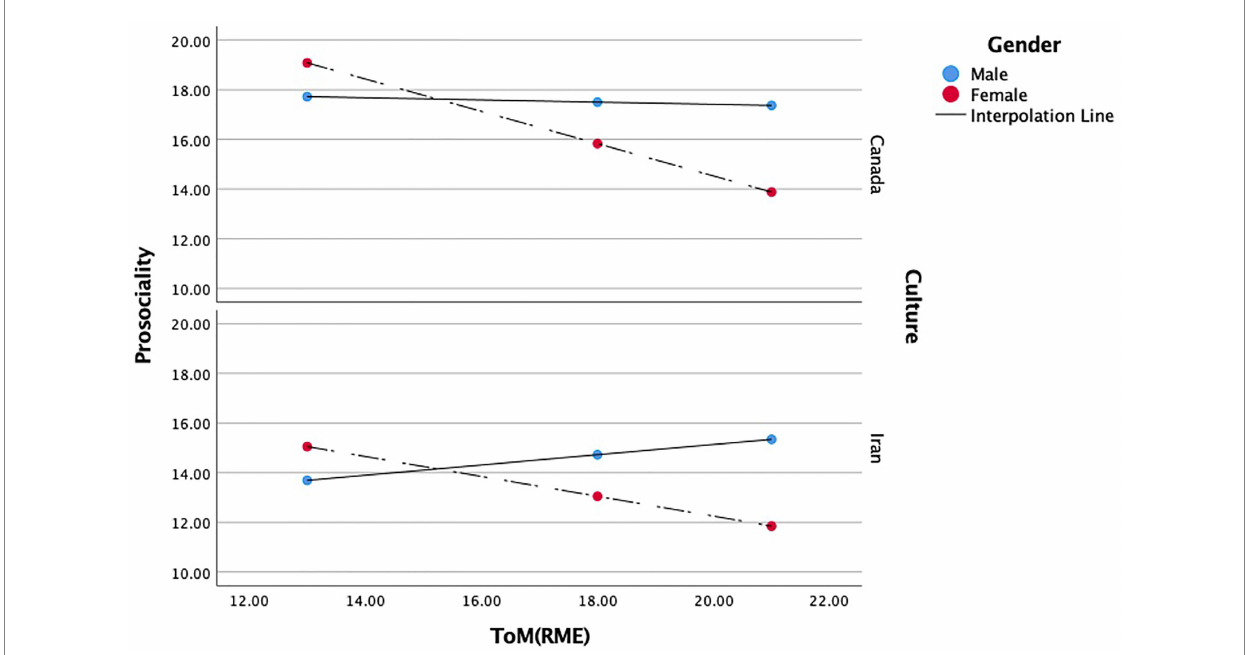
FIGURE 3 Moderating role of gender and culture in the relationship between ToM and prosociality.